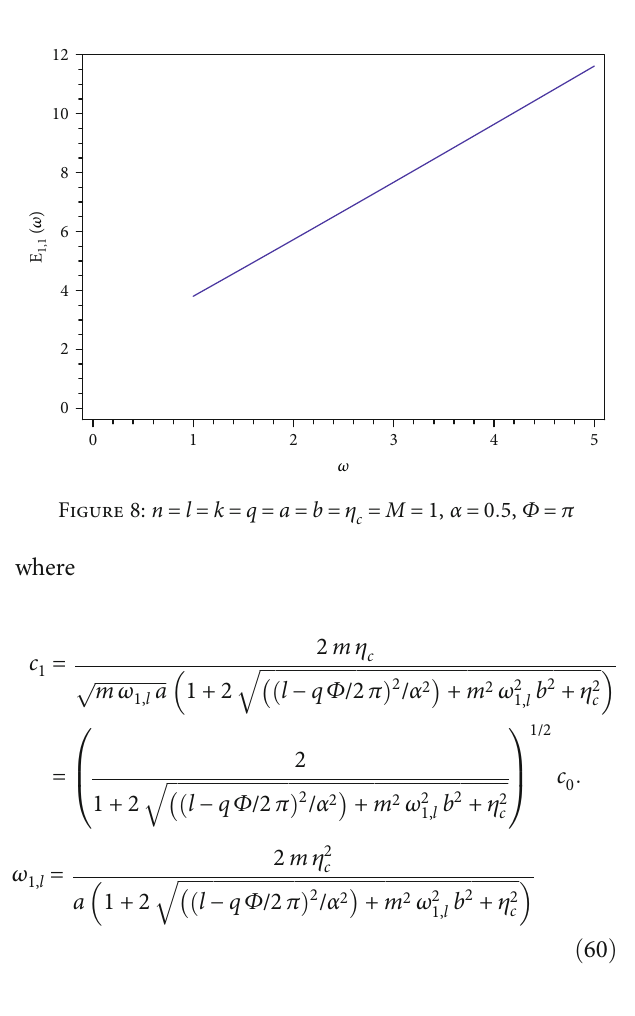
= M = 1 , α = 0 : 5 , ω = 0 : c